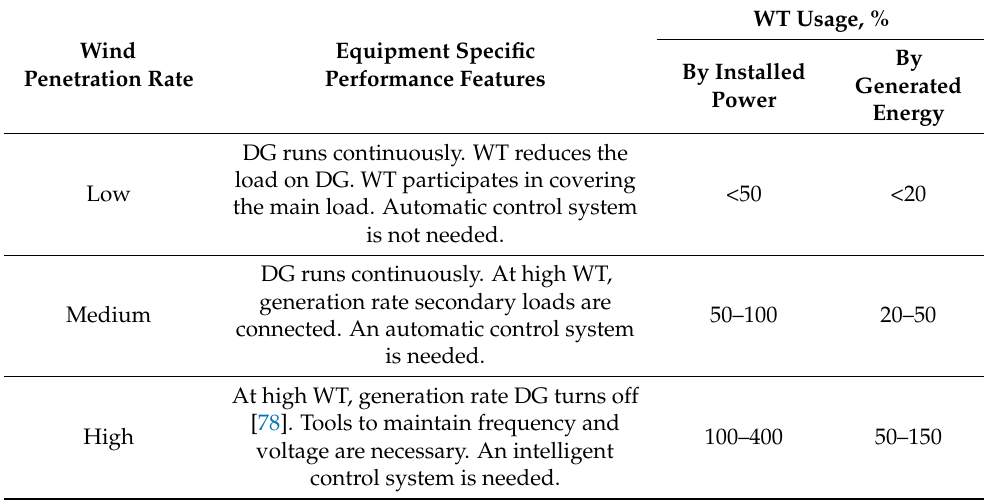
Table 3. WDHS wind penetration